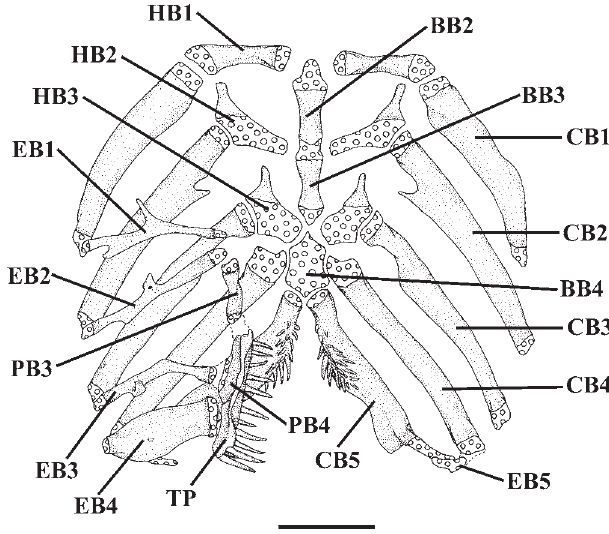
Fig. 8. Branchial skeleton of Trichomycterus maracaya (LIRP 4381), 43.9 mm SL, paratype. Dorsal view. Dorsal elements of right gill arches and gill rakers not shown. Abbreviations: BB2-4, basibranchials 2 to 4; CB1-5, ceratobranchials 1 to 5; EB1-5, epibranchials 1 to 5; HB1-3, hypobranchials 1 to 3; PB3-4, pharyngobranchials 3 and 4; TP, tooth plate. Scale bar = 1